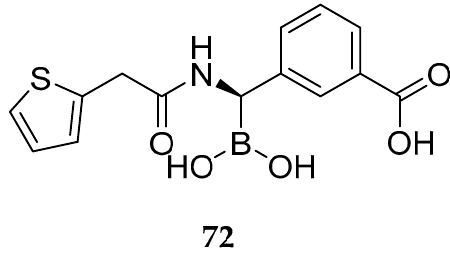
Figure 7. Compound SM23 ( 72 ), an inhibitor of class C β -lactamases and of biofilms formation.